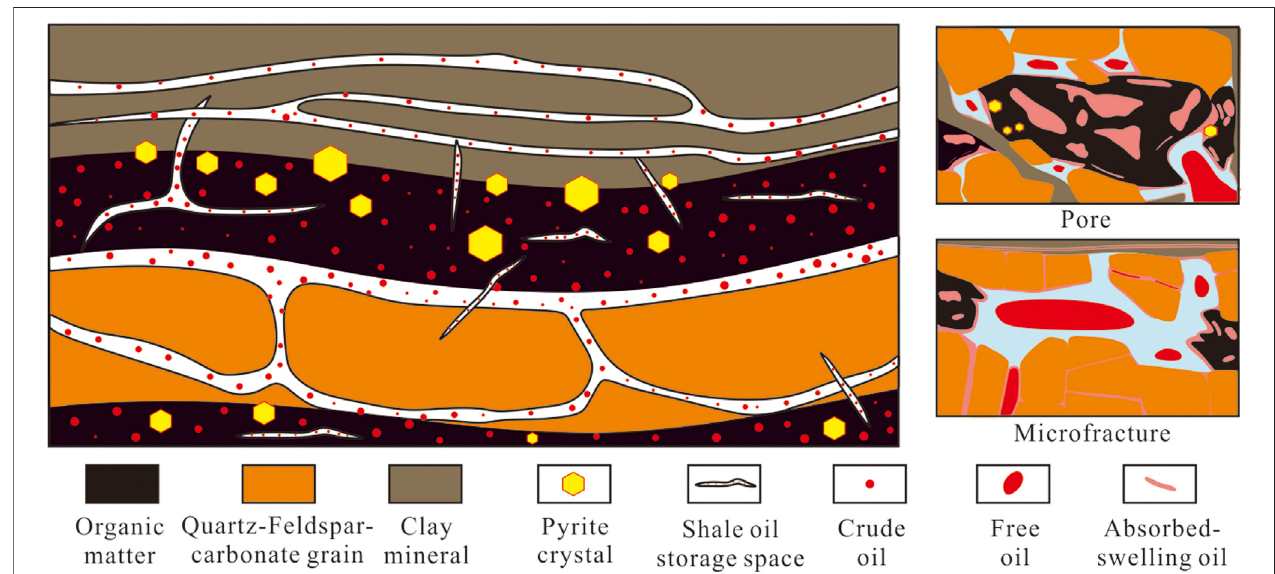
FIGURE 2 | Shale oil retention patterns. Shale oil is mainly in adsorption and free states (modi fi ed from Zou et al., 2013; Hu et al., 2021).